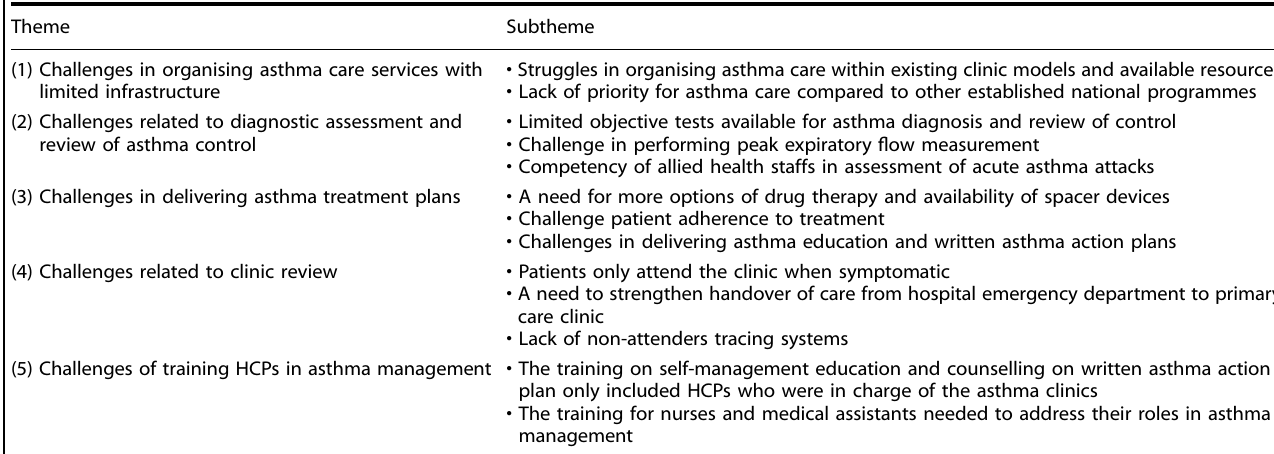
Table 2. Themes and subthemes of the